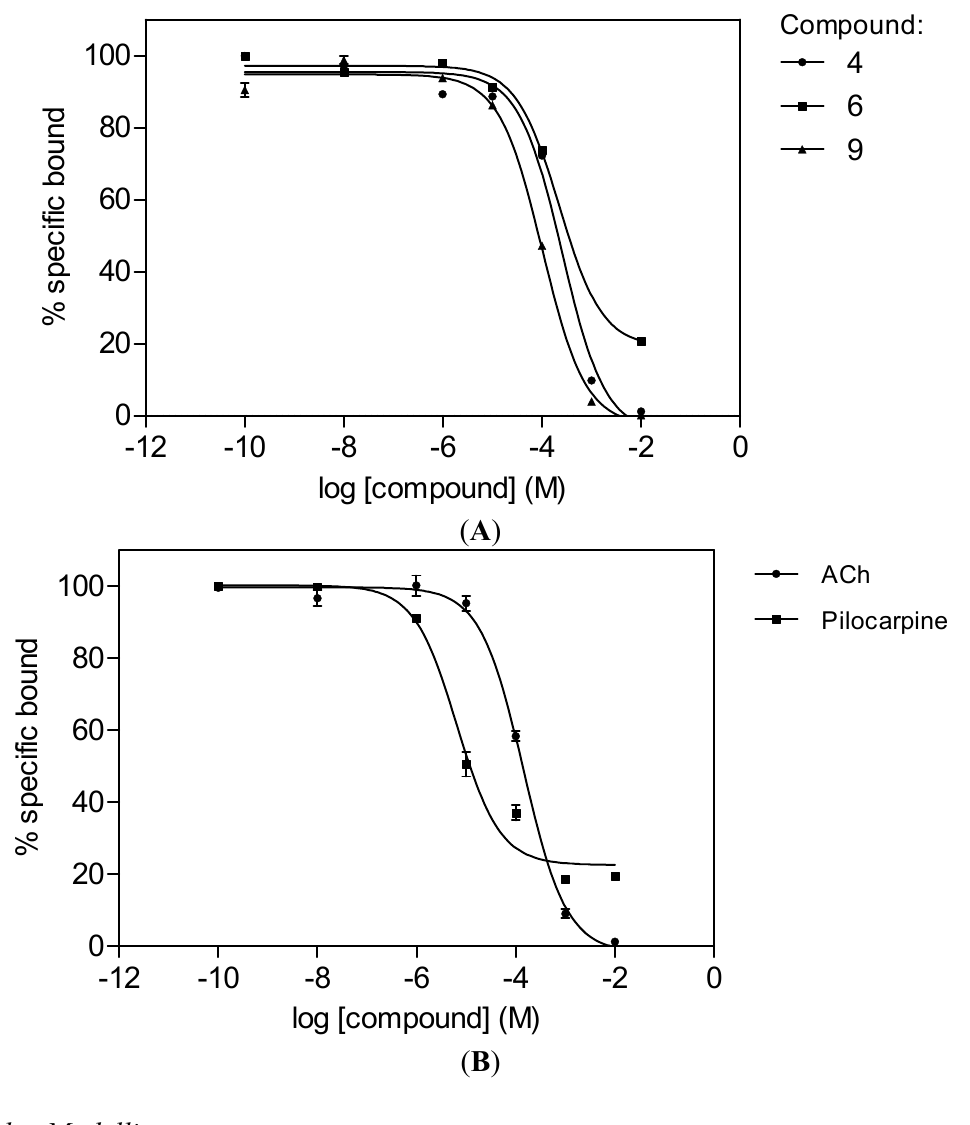
Figure 2. Displacement curves for the binding of [ 3 H]N-methylscopolamine to the M mAChR in the presence of ( A ) 3',4',5',5,6,7-hexamethoxyflavone ( 4 ), luteolin ( 6 ) and ombuin ( 9 ) and ( B ) acetylcholine (ACh) and pilocarpine. Receptor membranes (13 µg protein/well) were incubated with N-methylscopolamine (0.2 nM) in the presence of the compounds at 27 °C for 120 min. Each data point is expressed as a mean ± SEM ( n =